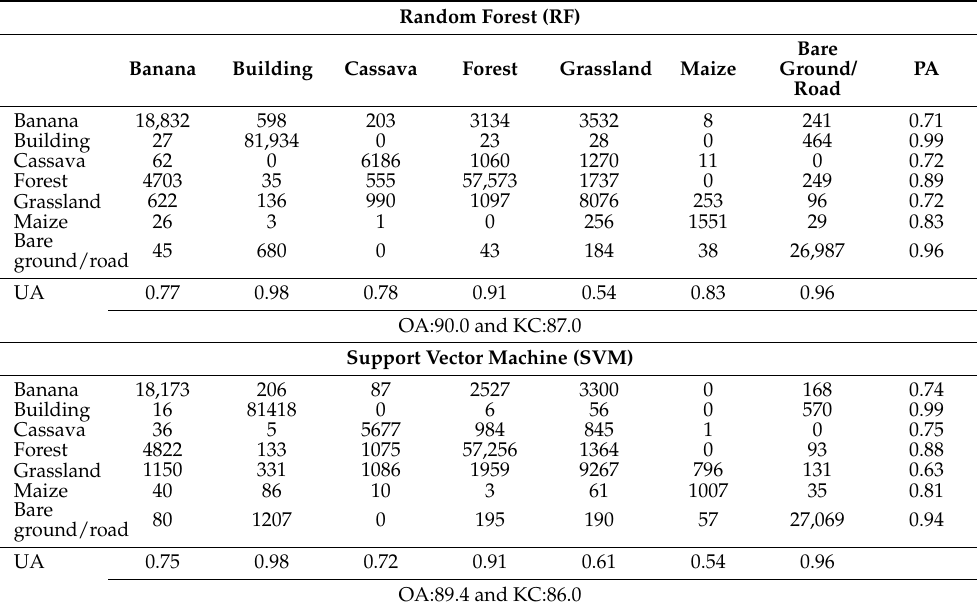
Table 6. Confusion matrices of RF and SVM for the complete UAV dataset at the Olokuta site in Nigeria.